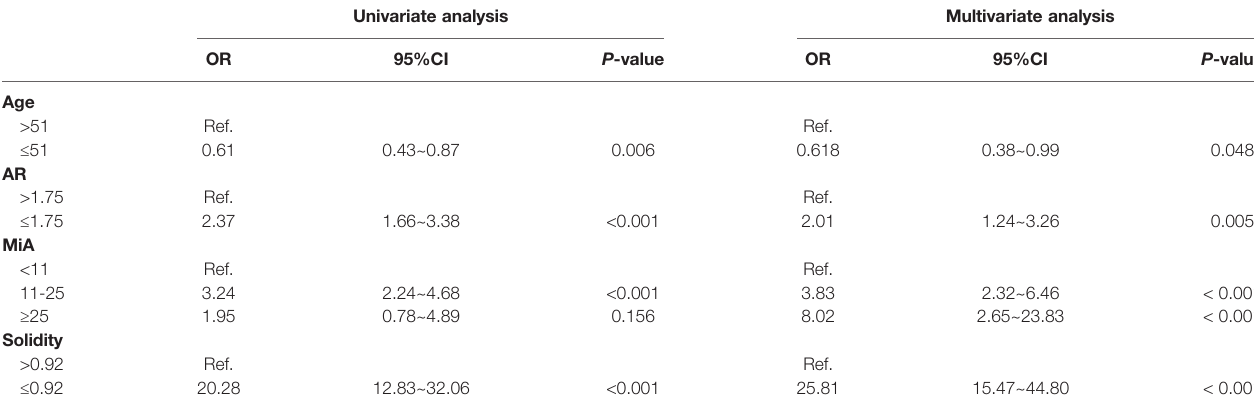
TABLE 2 | Results of univariate and multivariate analyses for breast malignancy in the training group. Univariate analysis Multivariate